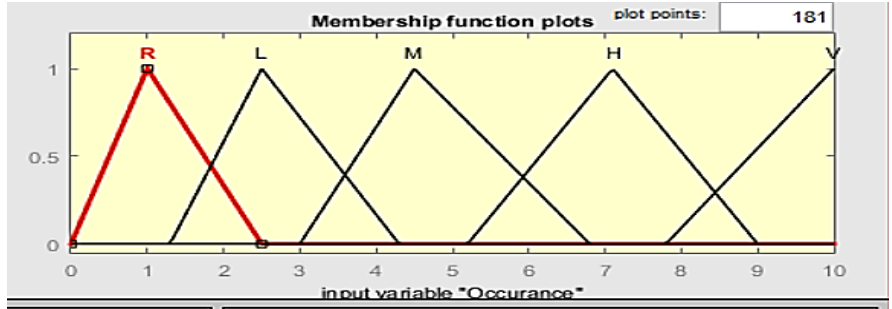
Figure 3. Membership Function for Occurrence (Matlab).